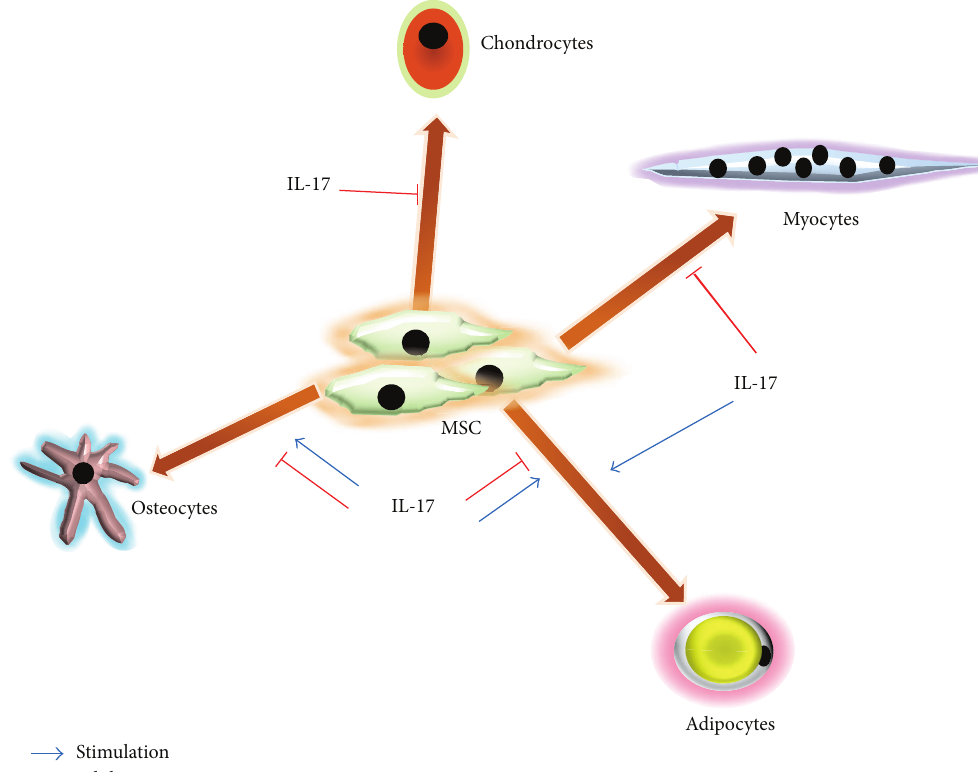
Figure 2: Effects of IL-17 on the differentiation of MSCs. IL-17 stimulates or inhibits MSCs differentiation into osteocytes, adipocytes, chondrocytes, and myocytes, depending on the host, origin of MSCs, and microenvironmental factors.